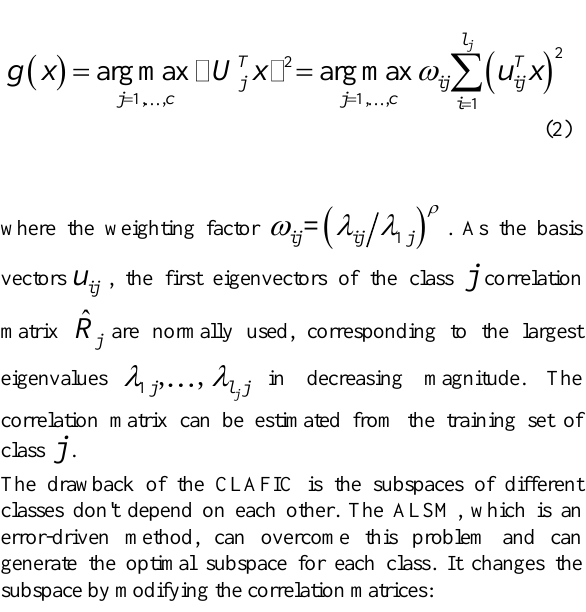
Figure 1. The location of the test site